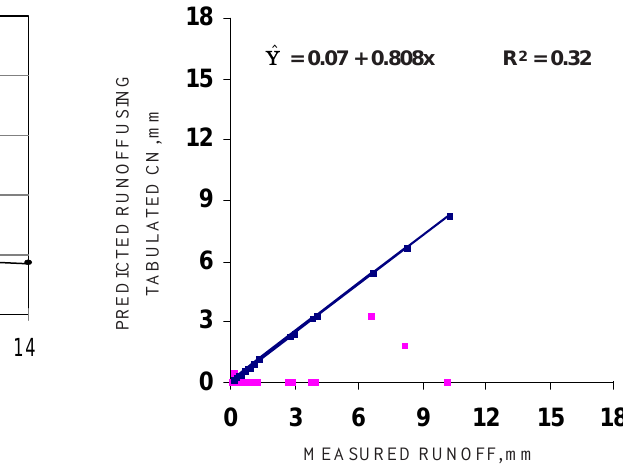
Figure 3. Simulated vs. measured individual storm- runoff event in Capetinga watershed using tabulated values of CN.